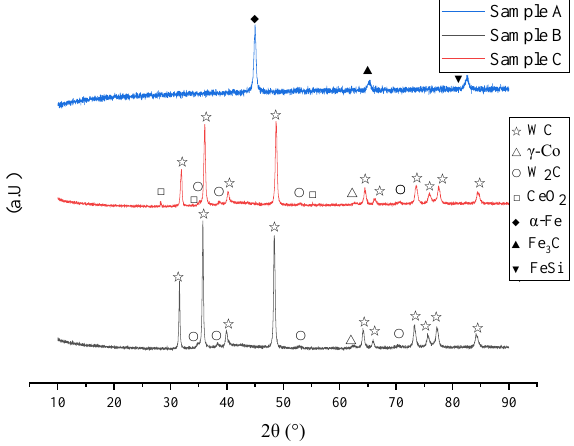
Figure 3. XRD Phase Analysis of Sample A, B, and C.